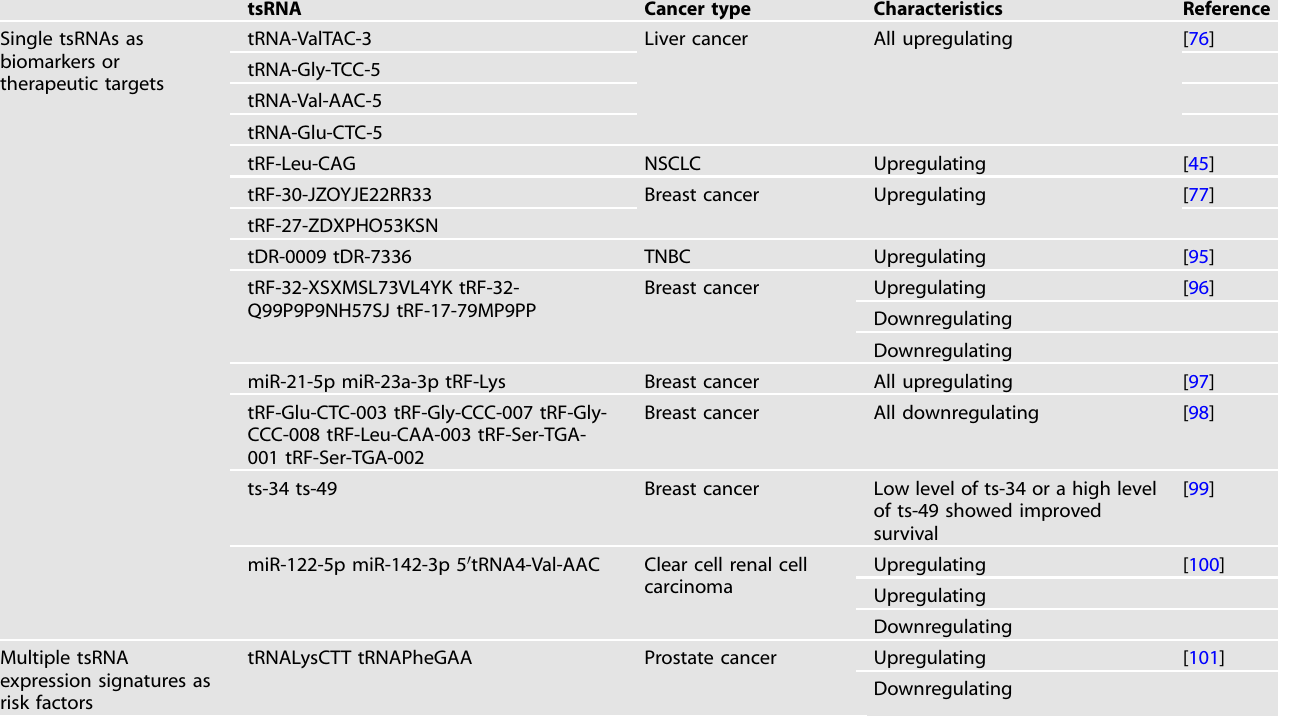
Table 2. Applications of tsRNAs in cancer